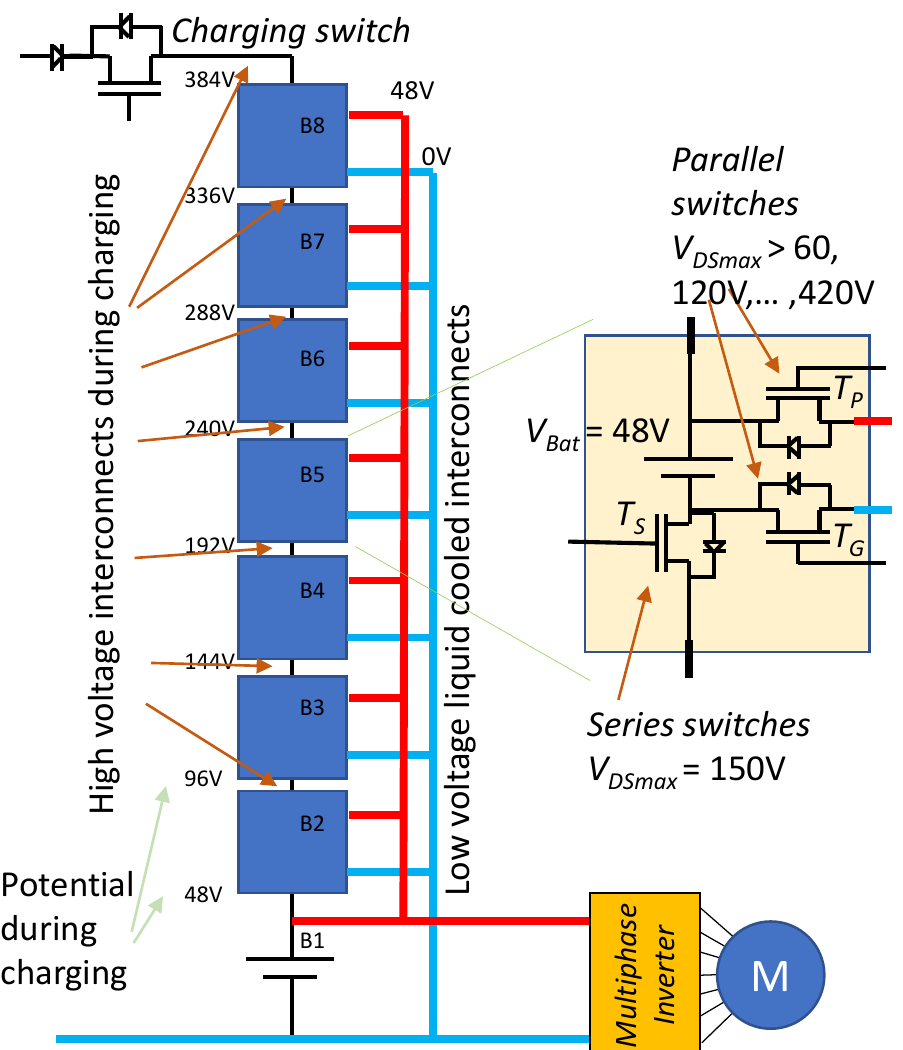
Figure 1. Schematic view of proof-of-concept battery reconfiguration system. Each module uses five N-channel MOSFETs for switch groups T P and T G , as well as two for T S